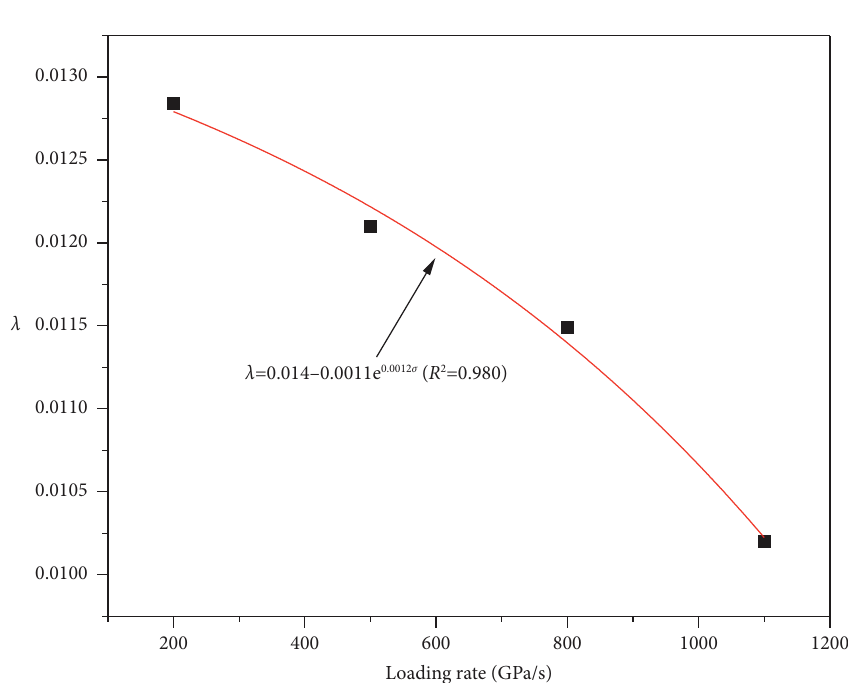
Figure 10: Change law of the decay factor versus the loading